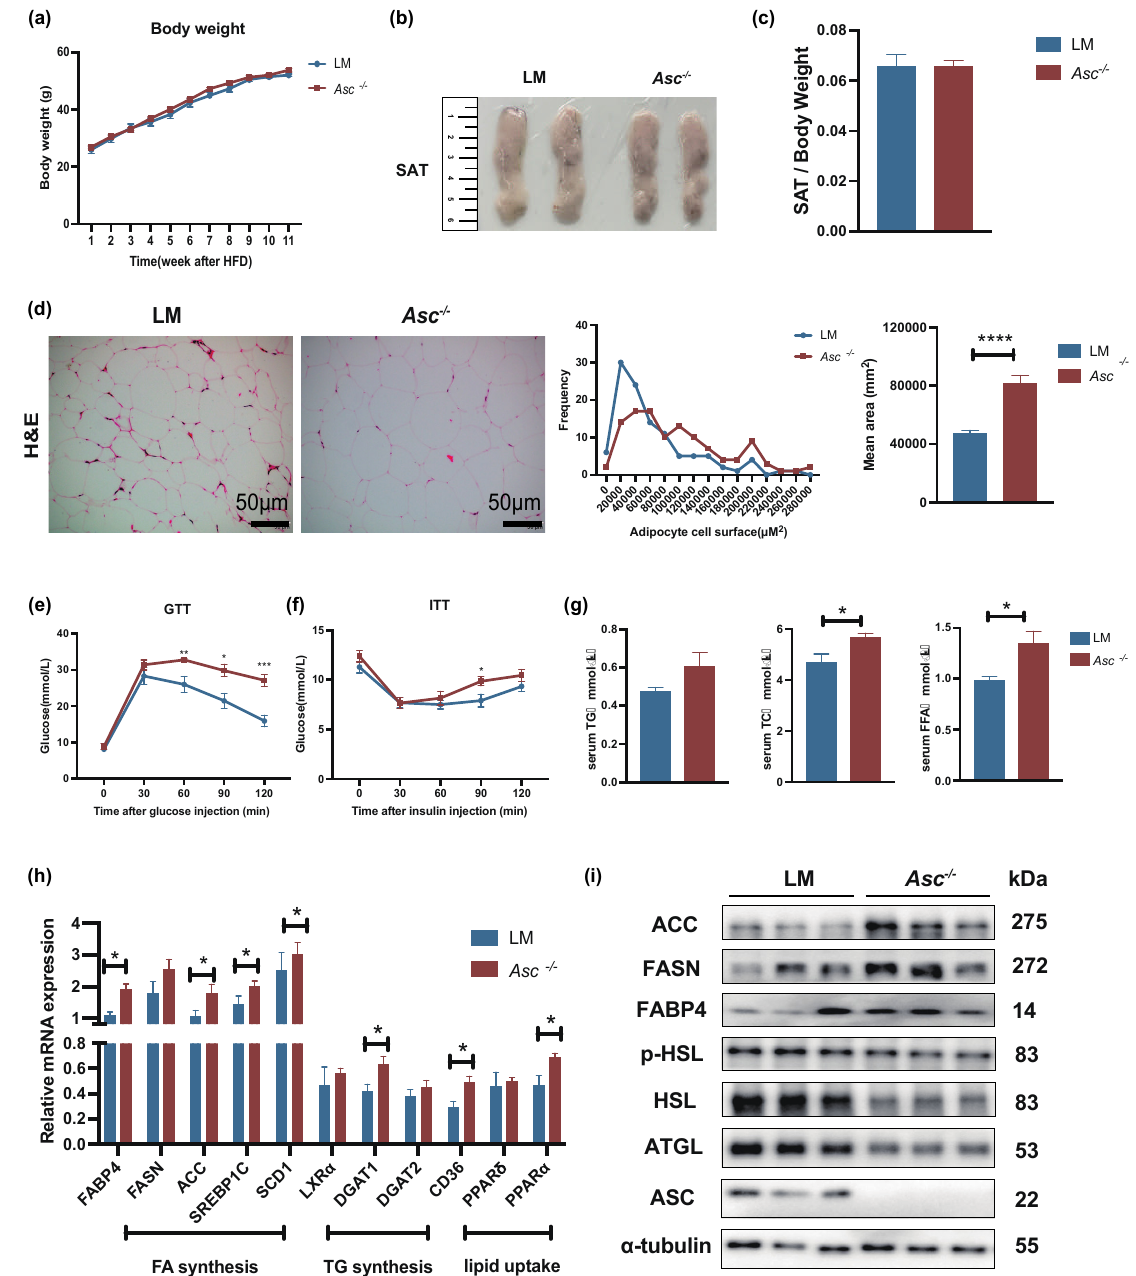
Figure 2. Increased lipogenesis and decreased lipolysis were observed in subcutaneous adipose tissue of Asc − / − mice fed with HFD. ( a ) Body weight change of LM (n = 8/group) and Asc knockout ( Asc − / − ) mice (n = 10/group), fed with HFD (12 weeks). ( b ) SAT groups are as described in ( a ). ( c ) Fat index (ratio of SAT weight to whole body weight of indicated mice. ( d ) H&E and quantification of SAT cell size, scale bar 50 µ m. ( e , f ) GTT and ITT analysis of indicated mice. ( g ) In indicated mice, plasma concentrations of triglyceride (TG), total cholesterol (TC), and free fatty acids (NEFA) at baseline. ( h ) mRNA expression of lipogenesis genes in SAT from indicated mice. ( i ) Western blot analysis of lipogenesis (ACC, FASN, FABP4) and lipolysis (p-HSL, HSL, ATGL) proteins in SAT. All the mice were male and fed with HFD for 12 weeks if not indicated otherwise. (n = 8–10/group) (Red-LM mice, Blue- Asc − / − mice). * p < 0.05, ** p < 0.01, *** p < 0.001 and **** p <